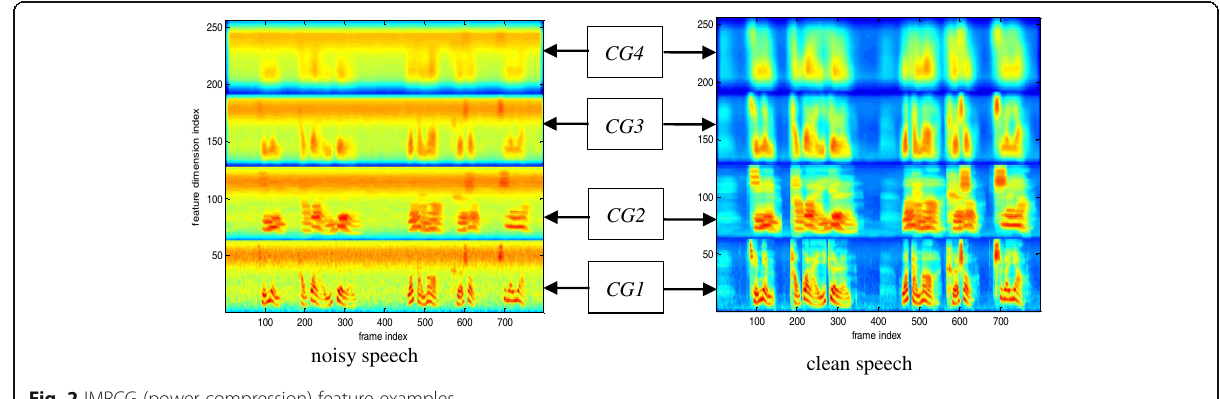
Fig. 2 IMRCG (power compression) feature